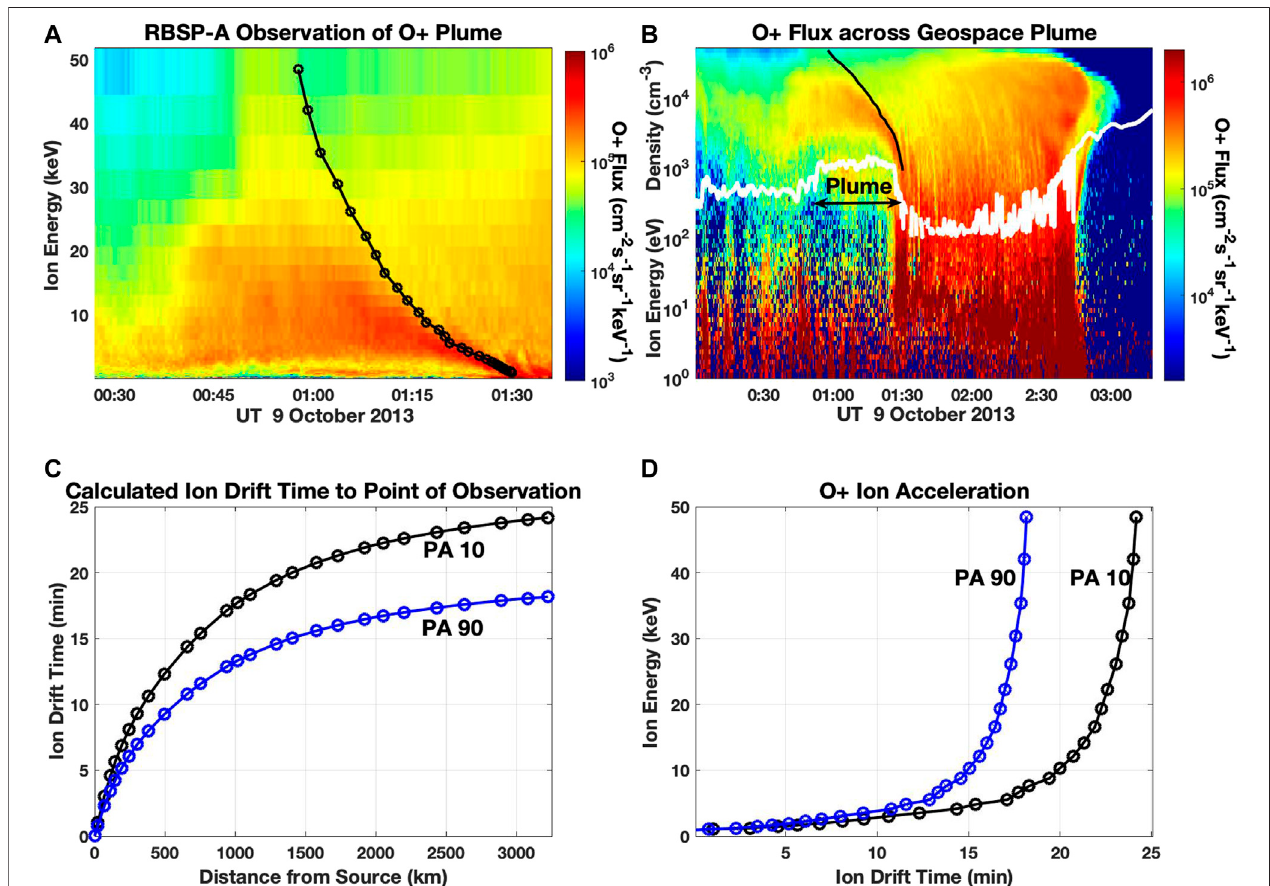
FIGURE 10 | (A) The O+ fl uxes on geospace plume fi eld lines shown in Figure 5A are replotted on a linear energy scale highlighting a pronounced > 1 keV O+ plume with a time-dependent upper energy boundary. The black curve marks the upper energy boundry of the O+ plume fl uxes. Circles denote the discrete ion energy channelsoftheHOPEinstrument. (B) O+ fl uxesandtheblackboundarylineofPanel(A)arereplottedversuslogarithmicionenergytoemphasizetheO+plume ’ soriginat the outer edge of the geospace plume. EFW cold plasma density is plotted as a white line. (C) Calculated O+ drift times to their points of observation (T N , see text) are plotted versus distance from their source at the plume for ions of a given energy for two values of pitch angle (see text). (D) The increase of O+ energy with drift time derived from the observed high energy boundary line shown in (A) is shown, indicating the rate of ion acceleration within the O+ plume for two values of ion pitch angle. Comparing the two pitch angle curves for constant drift time away from the ion source it is seen that pitch angles increase with energy during the keV O+ plume acceleration.